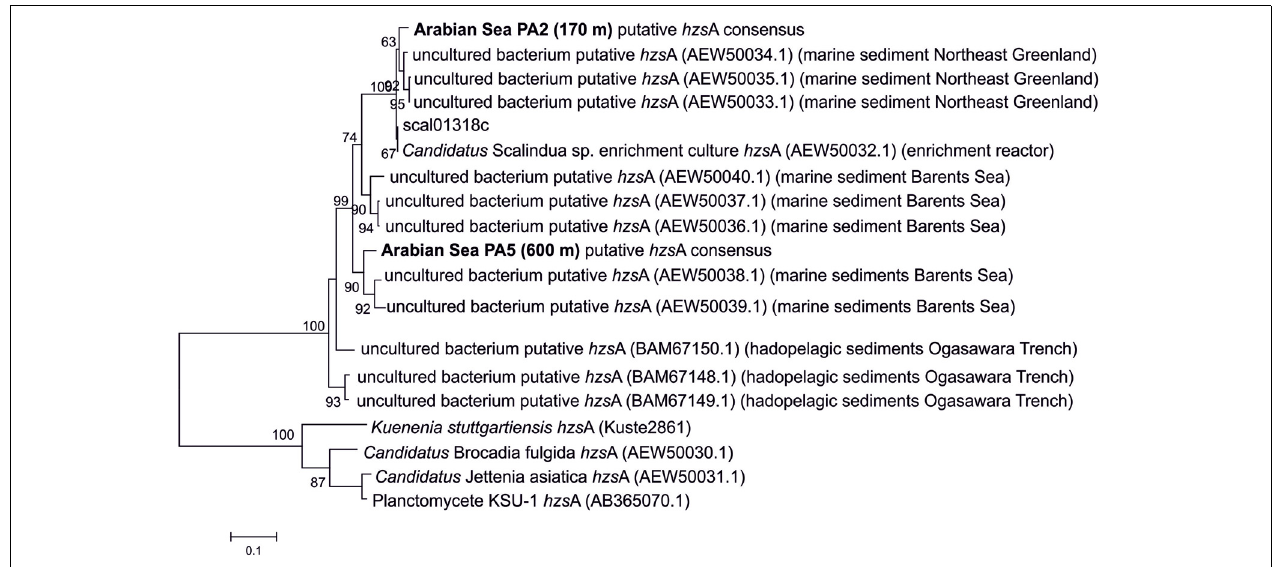
FIGURE 2 | Maximum likelihood tree of translated hzs A sequences based on 426 amino acid positions. The reference sequence and consensus sequence used in this study are in bold. Branch support was